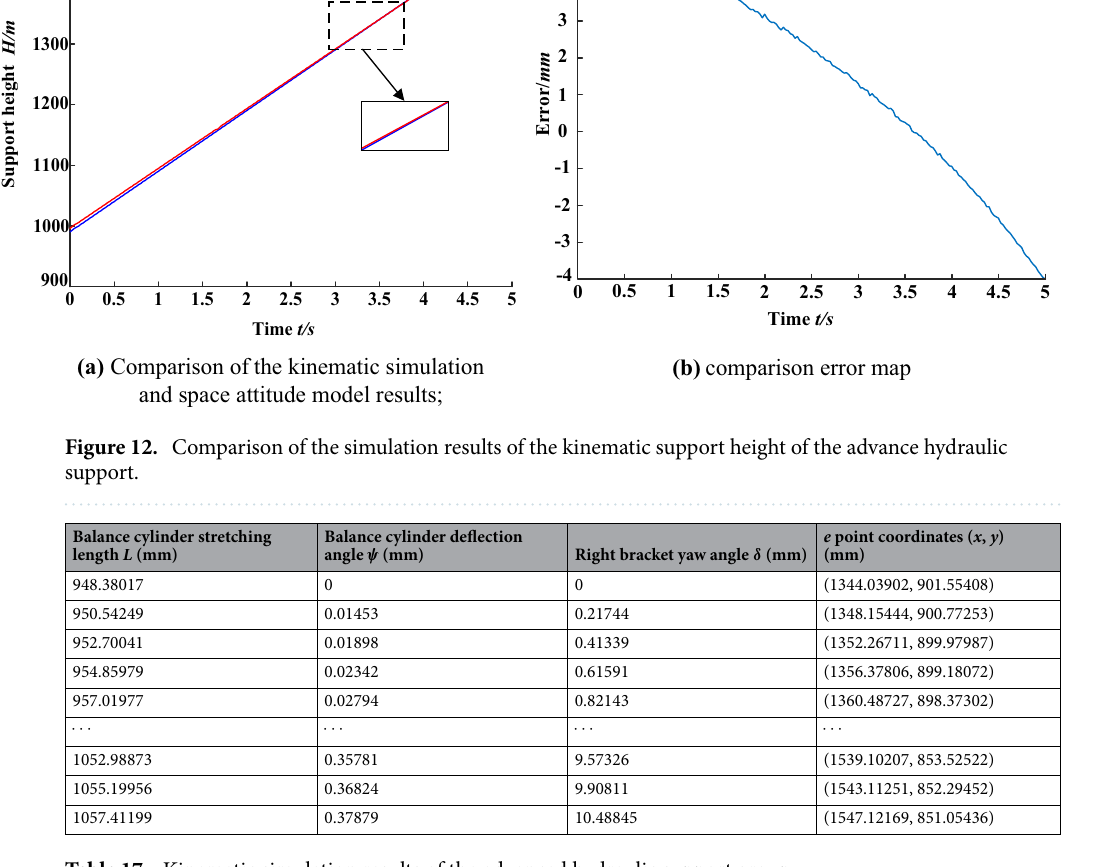
Table 17. Kinematic simulation results of the advanced hydraulic support group.